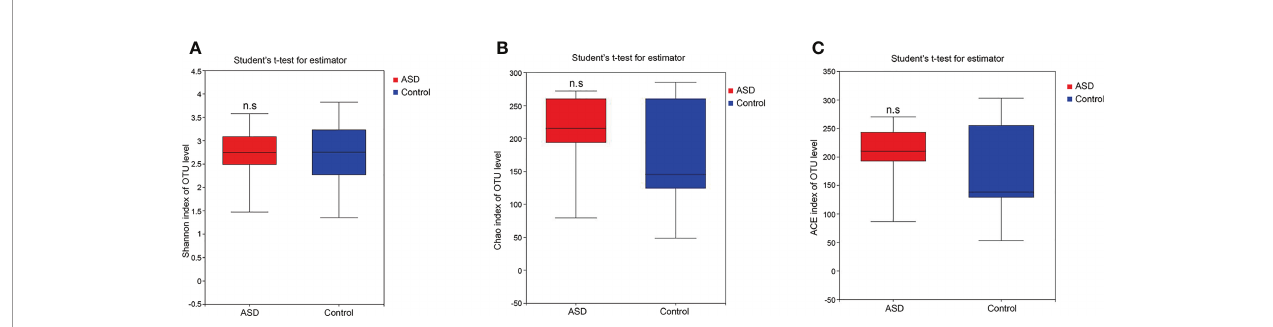
FIGURE 2 | The within-sample phylogenetic diversity analysis ( a -diversity): There was no signi fi cant differences of Chao1, ACE and Shannon indexes between healthy controls and ASD group (red: ASD group; blue: control group). (A) Chao index of OUT levels; (B) ACE index of OUT levels Sobs index of OUT levels; (C) Shannon index of OUT levels. n.s. represented “ no signi fi cant